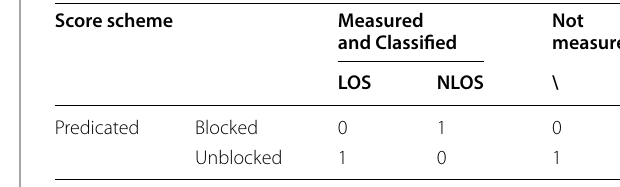
Table 1 A score scheme for shadow